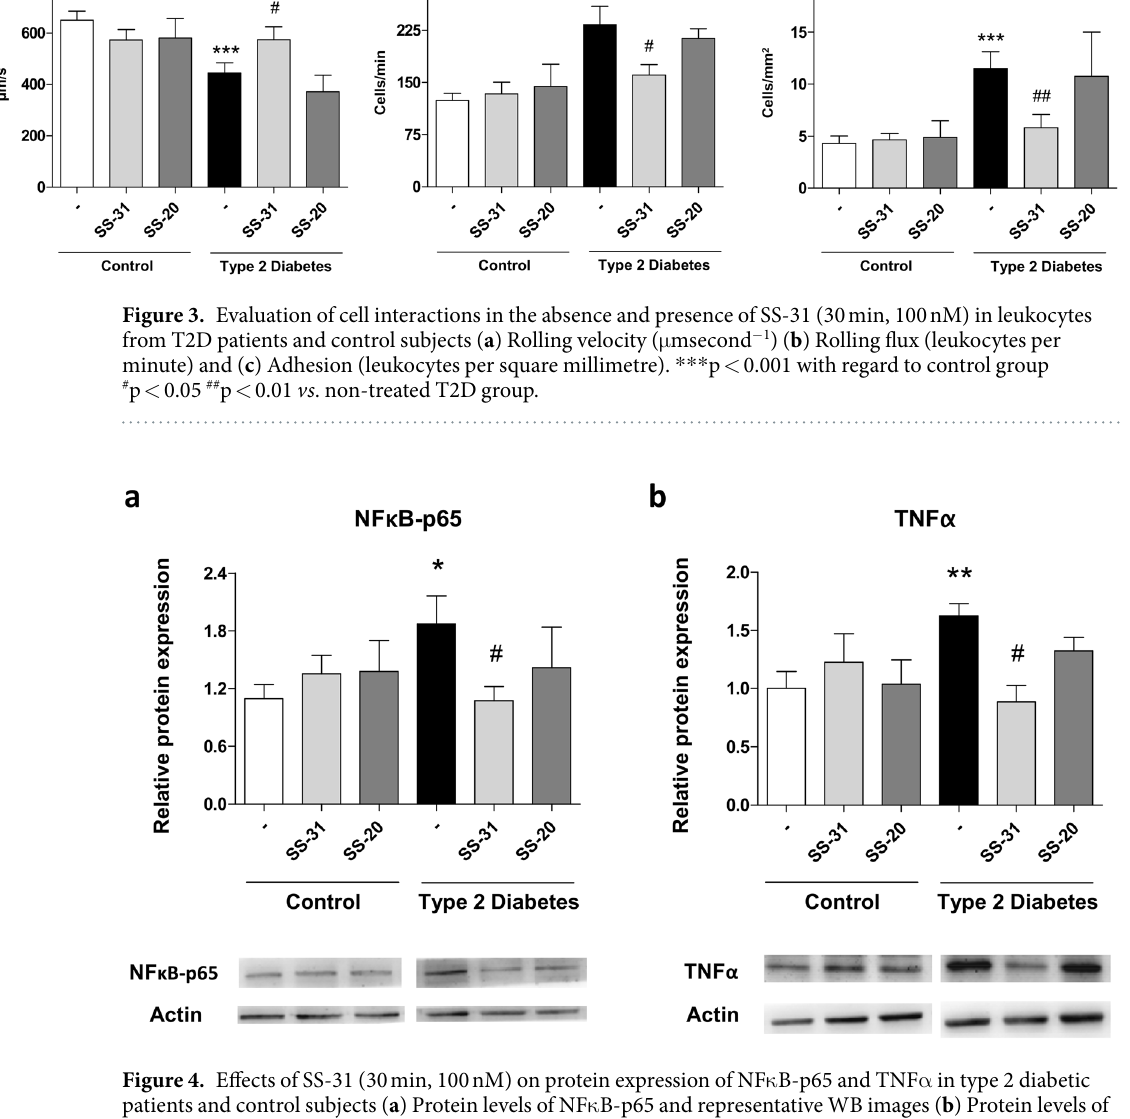
(2018) 8:15862 | DOI:10.1038/s41598-018-34251-8